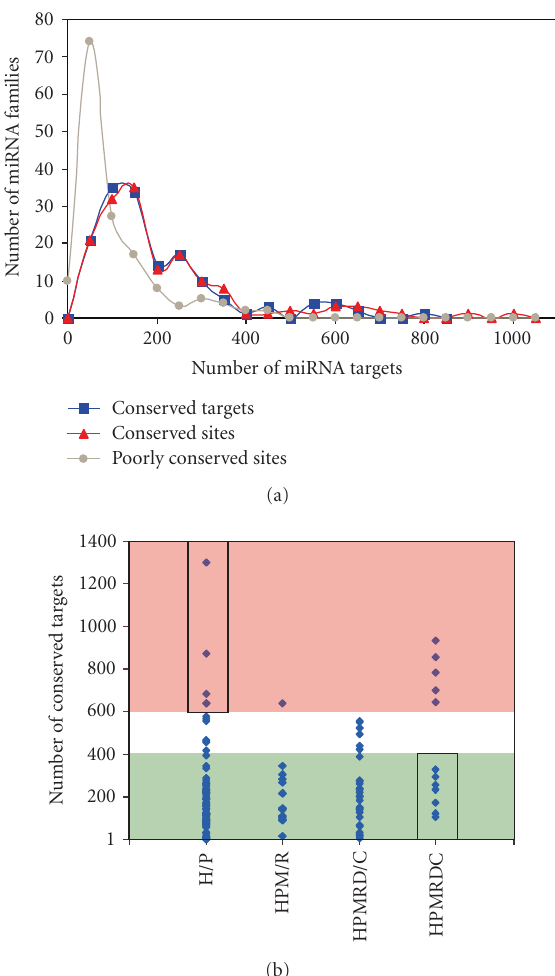
Figure 3: The number of predicted conserved miRNA target sites. (a) Predicted number of conserved targets, conserved target sites and poorly conserved sites of human miRNAs (based on TargetScanS). (b) The number of predicted conserved miRNA targets was divided according to the conservation level of the miRNA itself (H, Human; P, Chimp; M, Mouse; R, Rat; D, Dog; C, Chicken; based on TargetScanS). Shaded in red/green are the regions with the largest/least number of targets (resp.). Extreme numbers of targets are boxed and are discussed in the